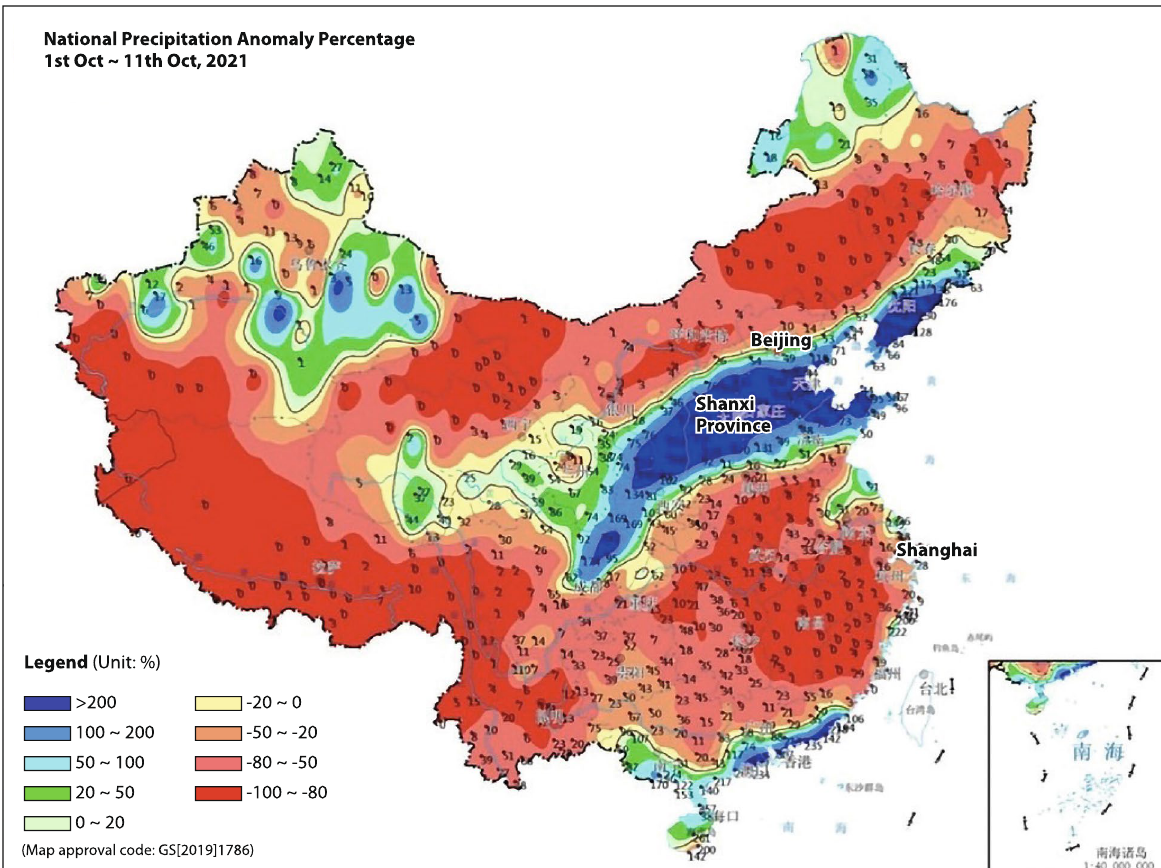
Fig. 2 National Precipitation Anomaly Percentage from 1 October to 11 October 2021 (Source: NMC: https:// cmdp. ncc- cma. net/ cn/ index. htm. Map approval code: GS[2019]1786)